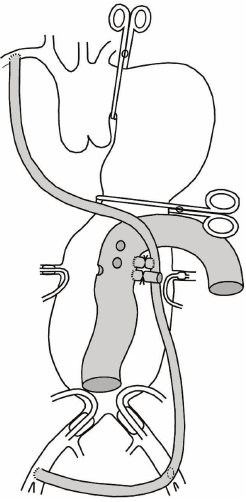
Figure 2: The presutured vascular prosthesis construct (shaded grey) consists of a temporary axillobifemoral bypass with a branch to the permanent aortic prosthesis. The drawing depicts an opened abdominal part of the aneurysm. Two Foley catheters are used for iliac occlusion. The left kidney is perfusion-cooled, and occlusion catheters occlude the right renal (shown) and visceral arteries (not shown).Holesinthemiddlepartoftheaorticprosthesis,placedafter measurements on preoperative computed tomography images, are ready to be anastomosed to the visceral and right renal ostia. After completion of these anastomoses, the ligature on the connection between the temporary bypass and the aortic prosthesis is removed, and the right kidney and intestines are perfused via the middle part of the aortic prosthesis which is isolated using temporary ligatures (not shown), while a side branch with another temporary ligature is anastomosed to the left renal ostium. Finally, the distal and proximal ends of the aortic prosthesis are anastomosed to the aortic bifurcation and to the aorta just distally to the left subclavian artery,